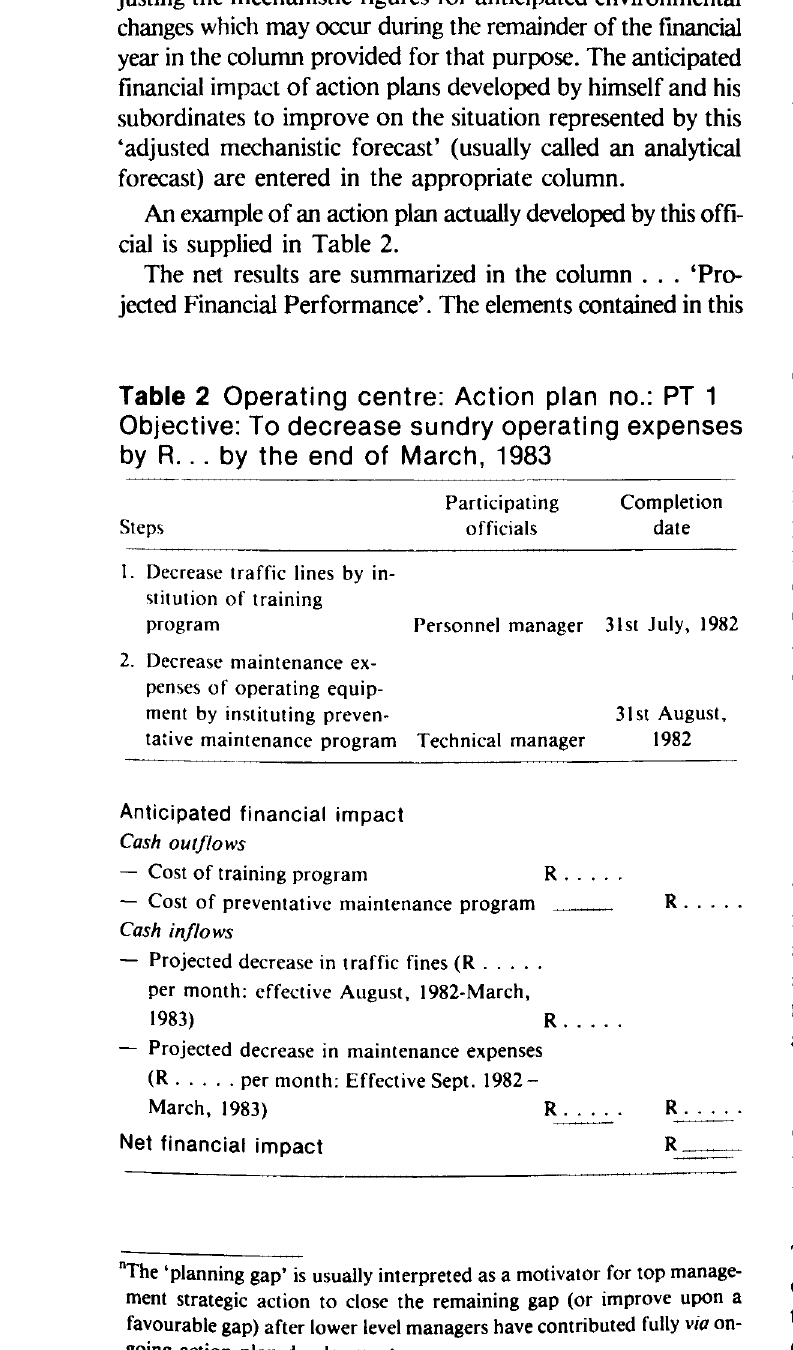
Table 2 Operating centre: Action plan no.: PT 1 Objective: To decrease sundry operating